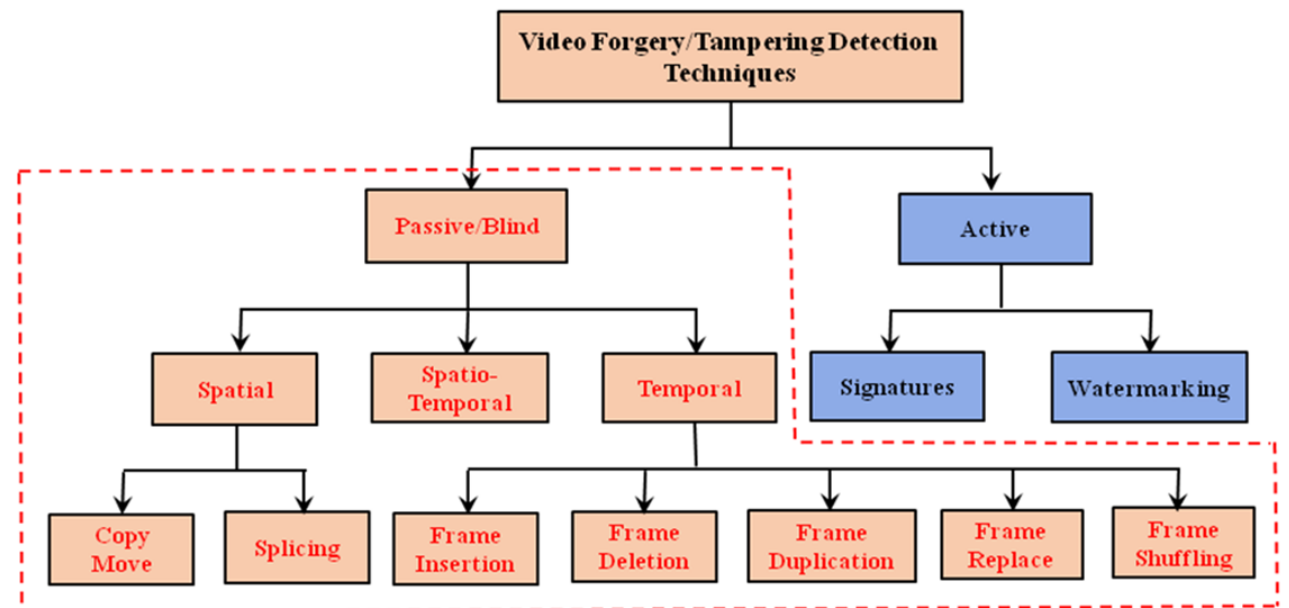
Figure 4. Categories of video tampering detection techniques.